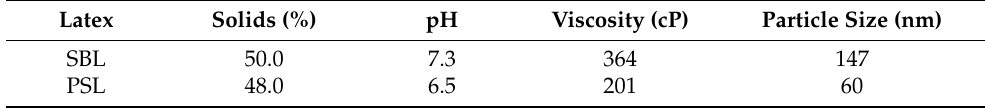
Table 3. Properties of latexes.